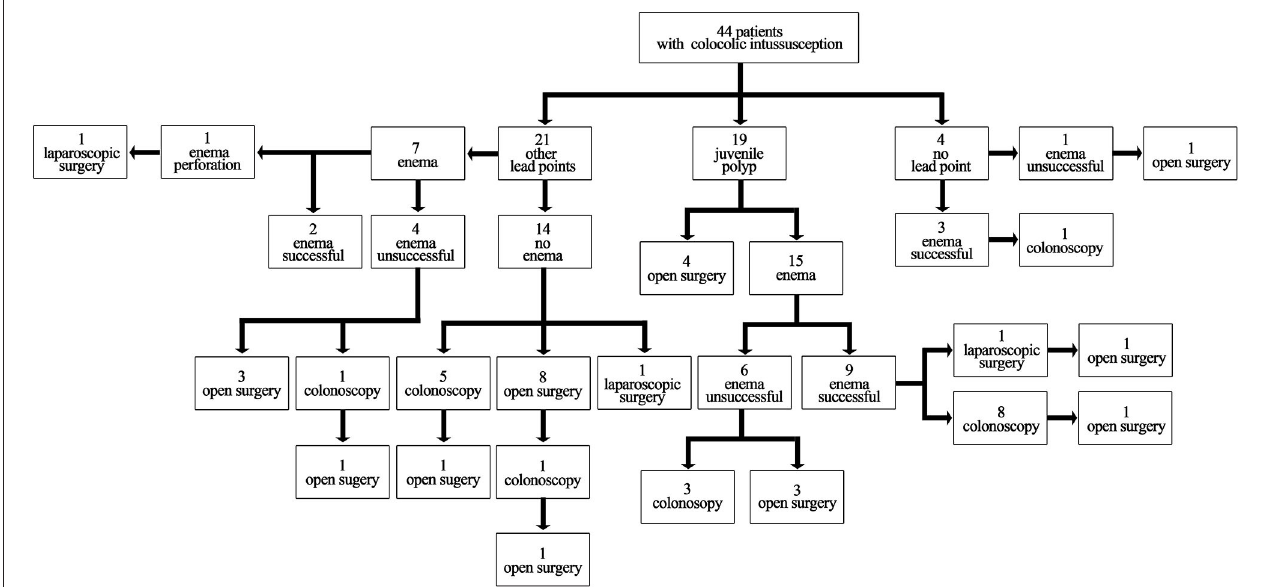
FIGURE 2 | Details of the treatment for patients with colocolic intussusception ( N = 44).